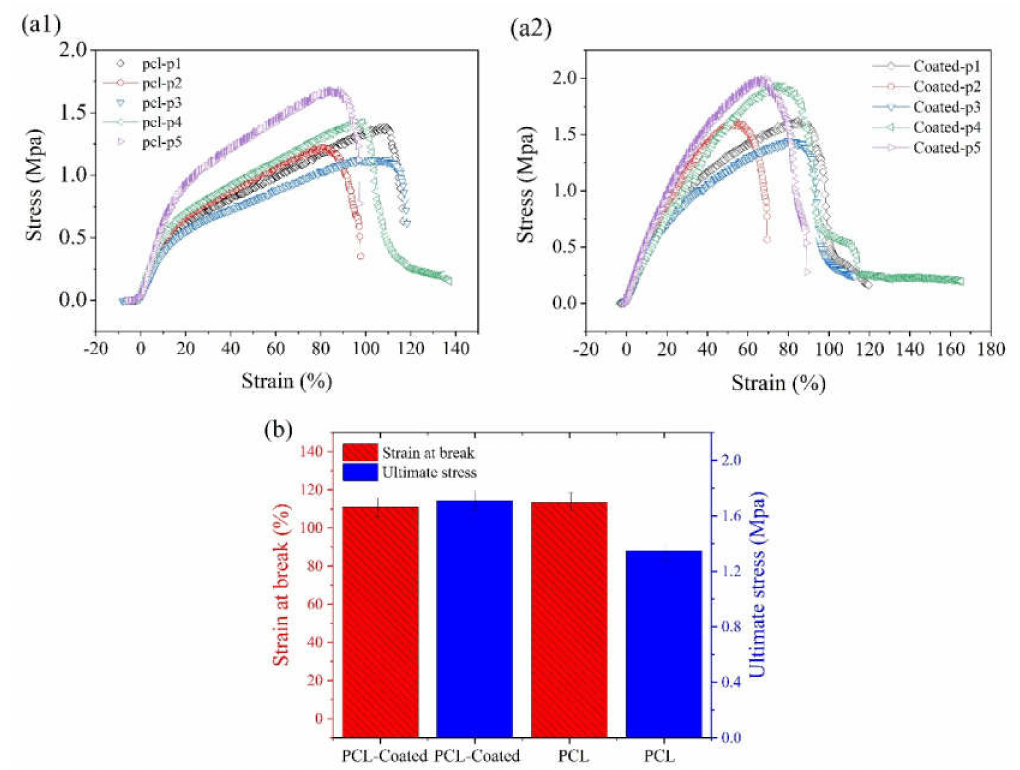
Figure 7. (a1,a2) Stress–strain curves of ( a1 ) pristine PCL membranes and ( a2 ) collagen / chitosan-coated specimens; ( b ) Comparative histograms of ultimate stress and strain for pristine PCL (PCL-p1 to p5) and coated specimens (coated: p1–p5) (The comparison of data between the two groups ( n = 5) using one-way ANOVA did not show any significant di ff erence for p <